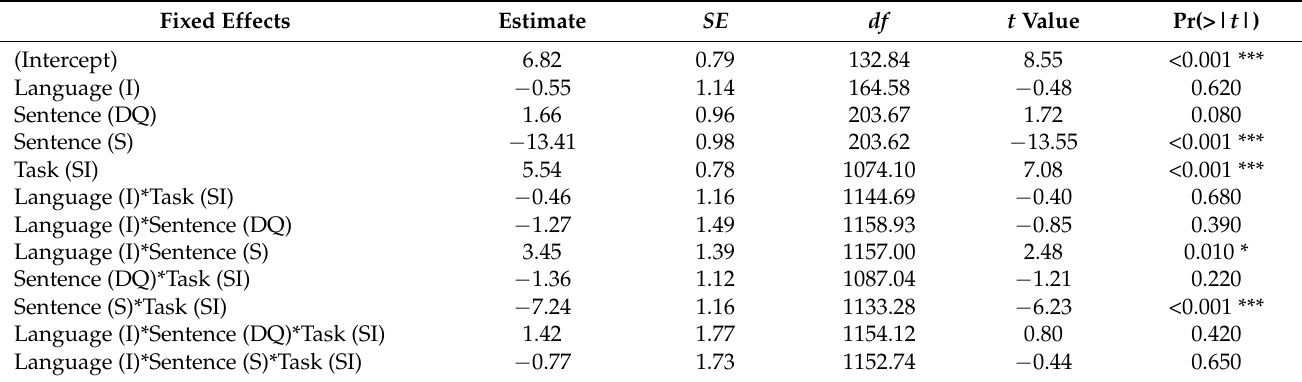
Table 10. (Nuclear contours): Linear mixed effect model with Language, Task and Sentence Type as